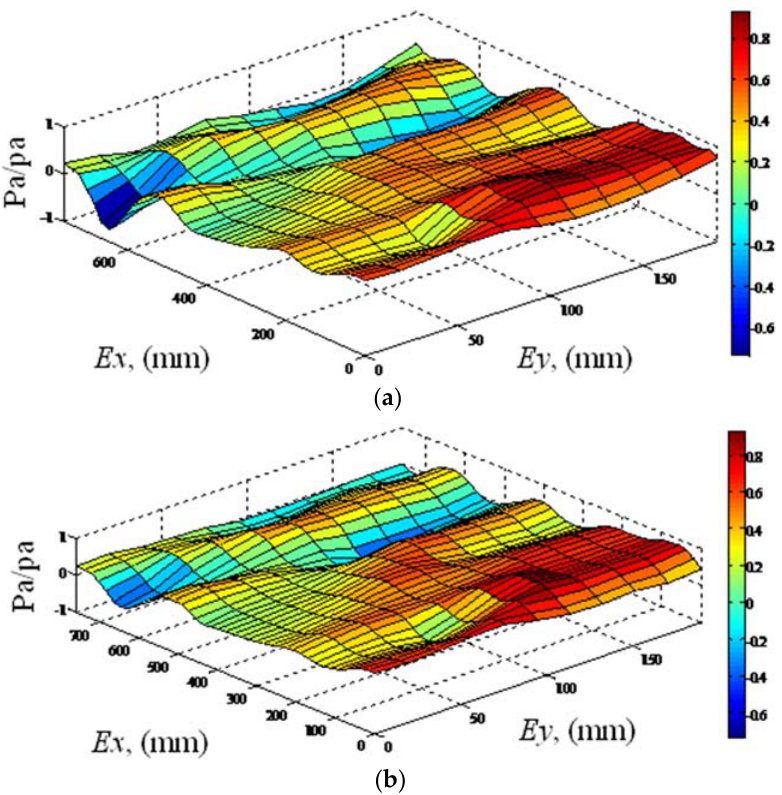
Figure 29. Normalized sound field results of scattering field: ( a ) uncloaked object; ( b ) cloaked object.